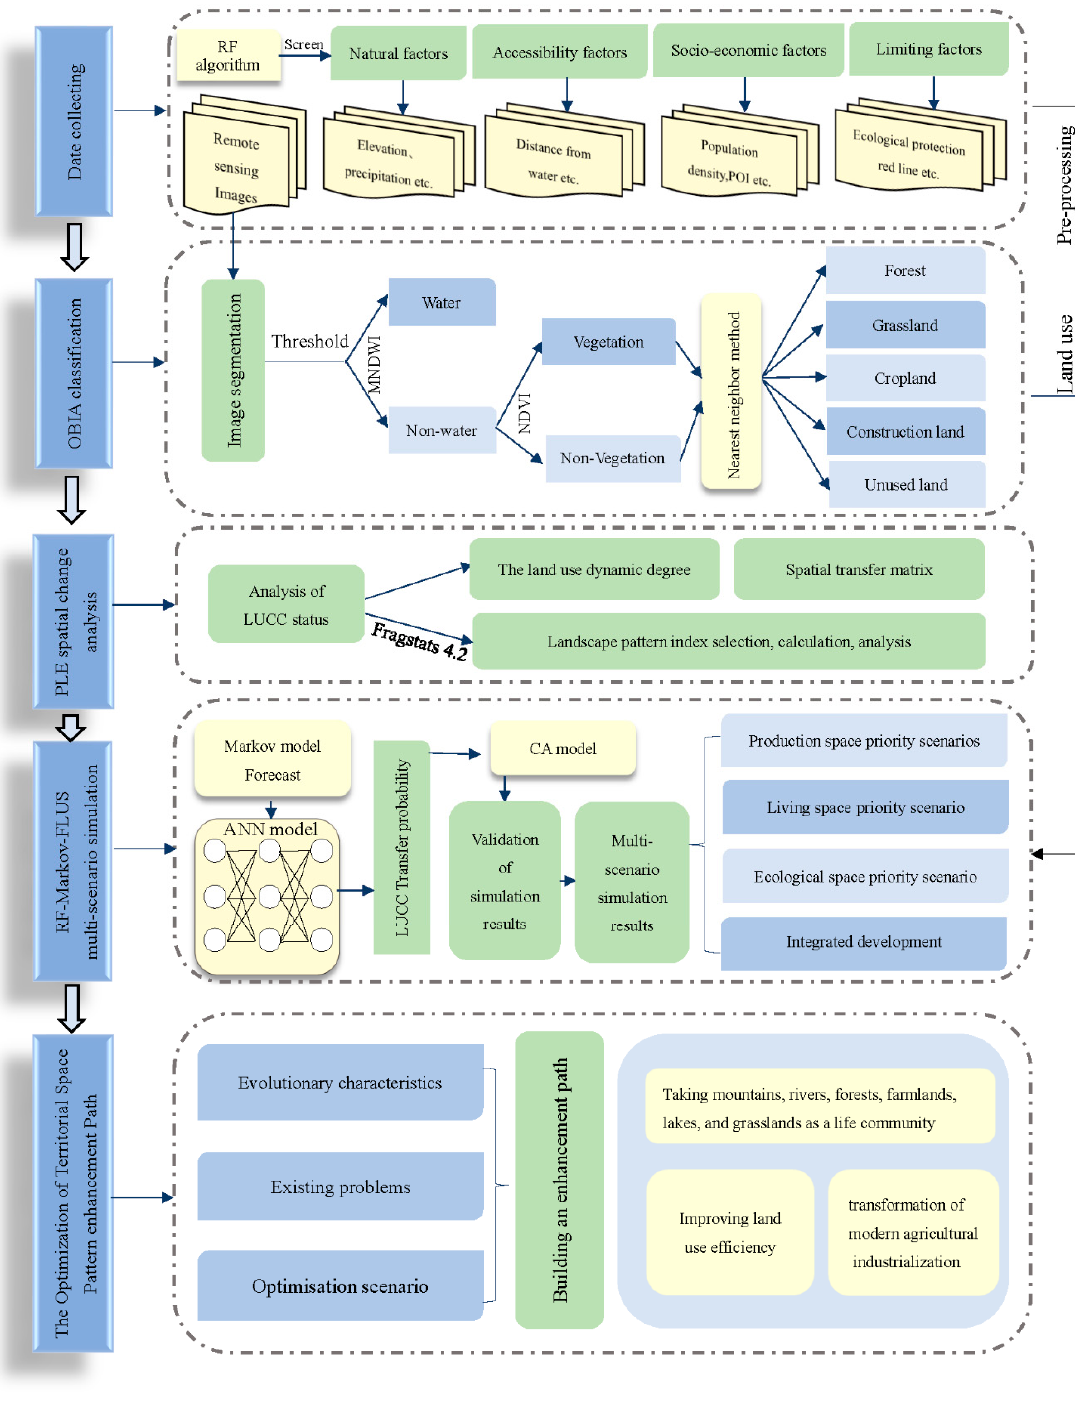
Figure 3. Workflow of this